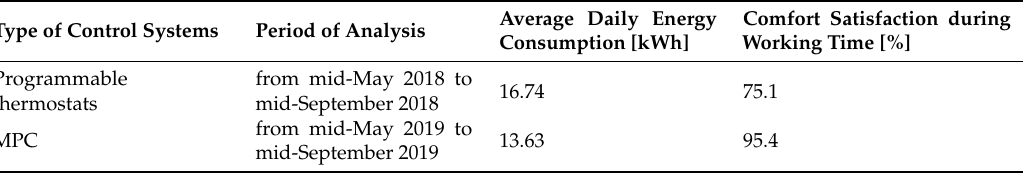
Figure 8. The actual indoor and outdoor temperature profile in a midweek day in June 2019. Table 2. Comparison of thermal control systems tested in the demo